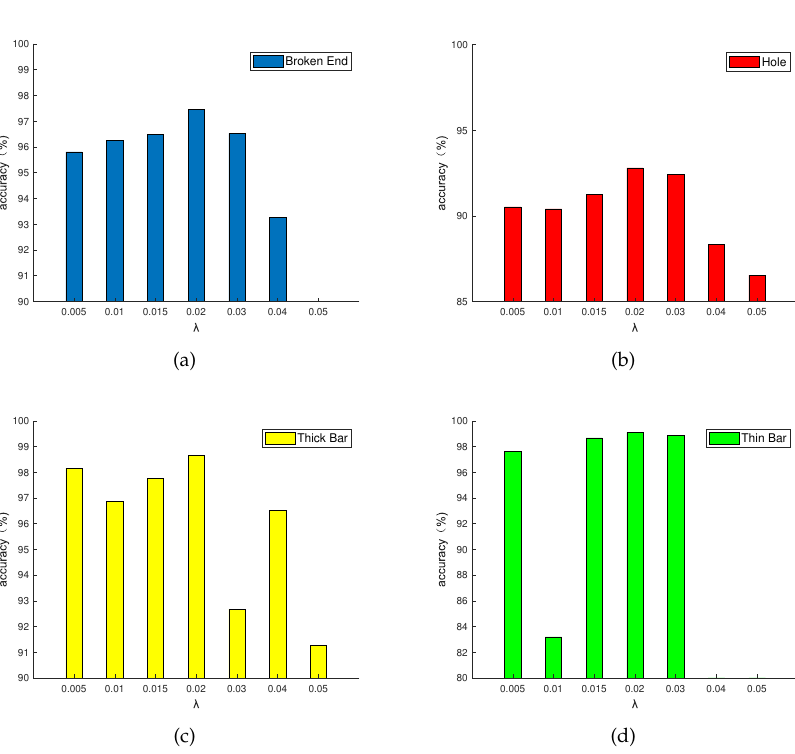
Figure 9. The influence of different parameter λ on the detection accuracy of four dot-patterned defect types. ( a ) broken end type; ( b ) hole type; ( c ) thick bar type; ( d ) thin bar type.